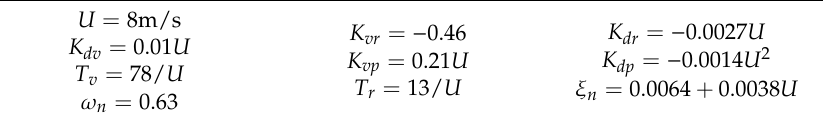
Table 1. The parameters of ship.